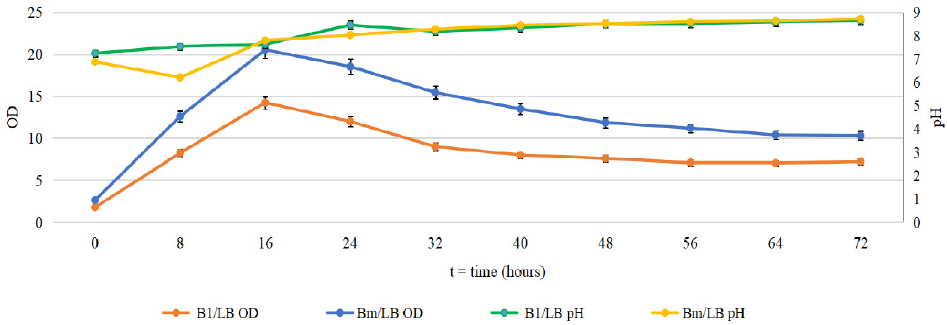
Figure 3. Growth of P. putida (B1) and B. mycoides (Bm) strains in LB medium.